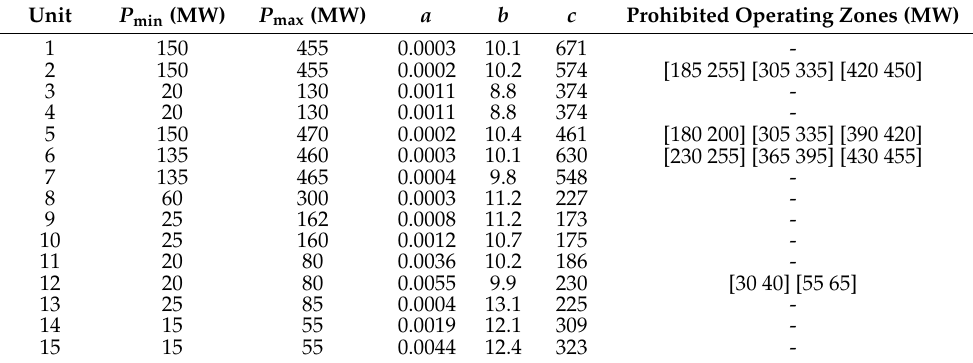
Table 9. Unit’s data for the 15-unit power system.